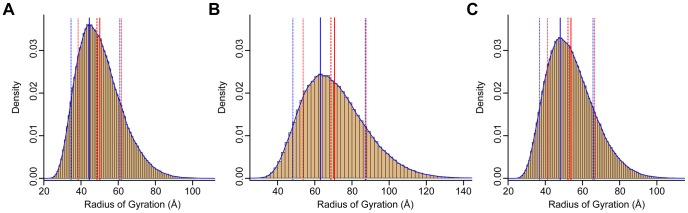
Histograms from TraDES sampling.(A) Coil-sampled ensemble. (B) β-sampled ensemble. (C) 3-state sampled ensemble. Solid blue line is the peak value. Solid red line is the mean value. Dashed red line is the median. Dotted red lines are at standard deviation, however the curves are not Gaussian, so the dotted blue lines bound the full-width at half max (FWHM).